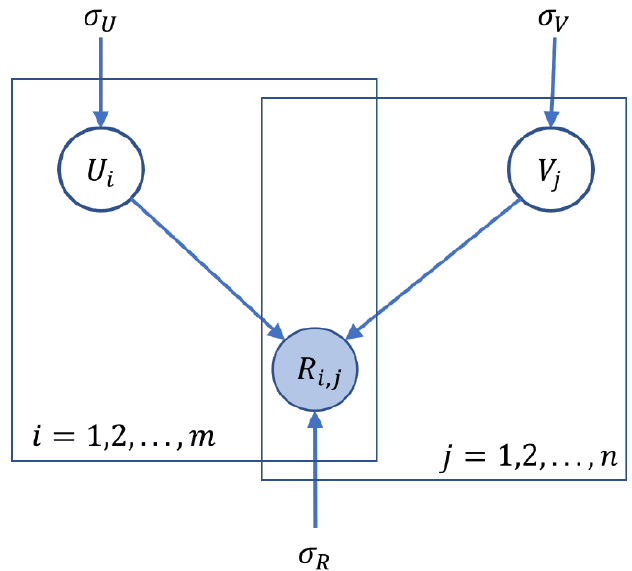
Figure 1. Illustration of probabilistic matrix factorization